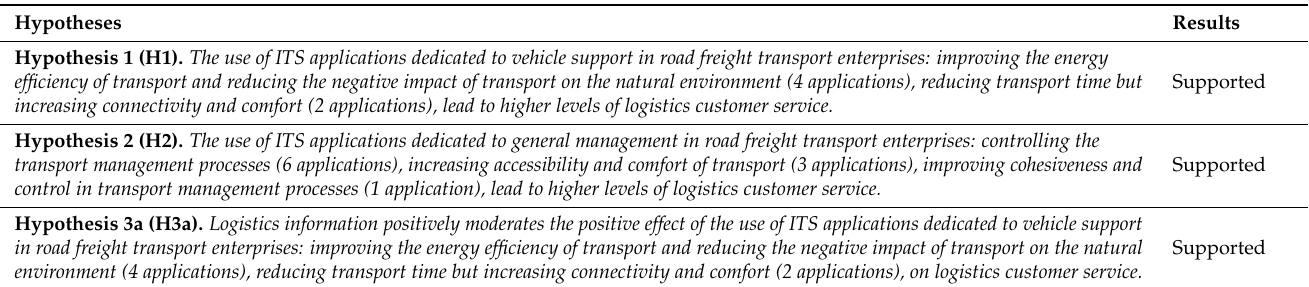
Table 6. Results of hypotheses